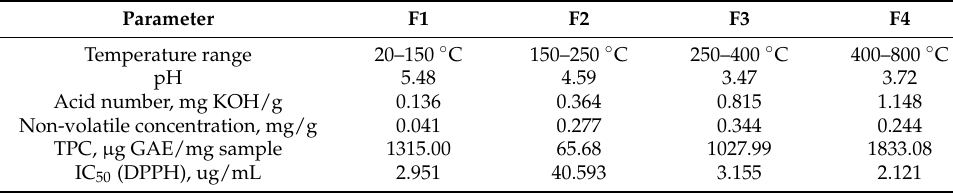
Table 1. General analysis results for the slow pyrolysis volatile product fractions.